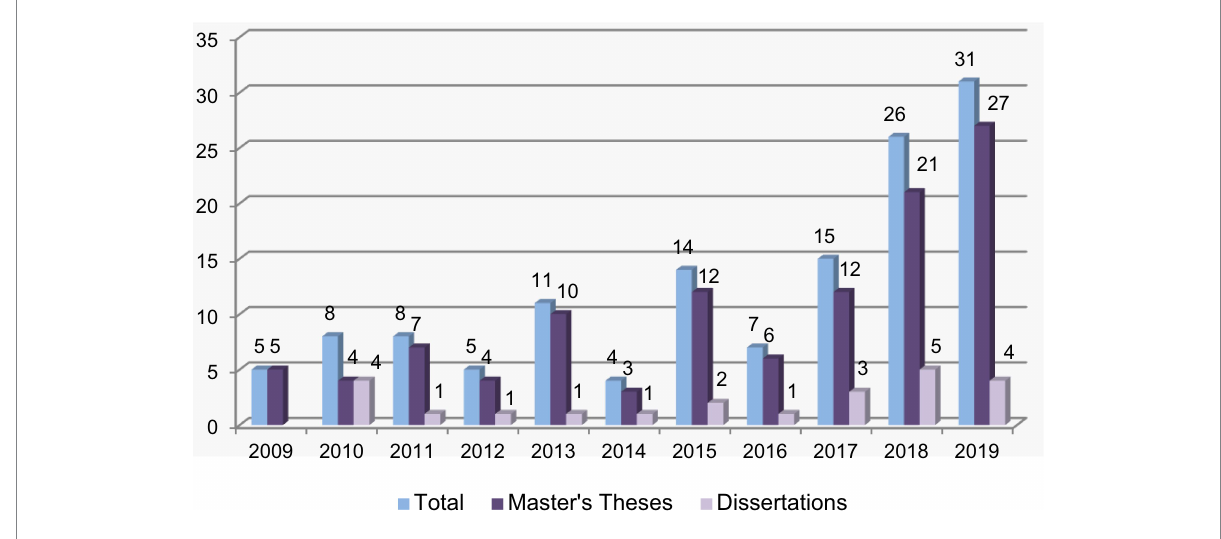
FIGURE 3 Distribution of master’s theses and PhD dissertations of the Turkish sample by